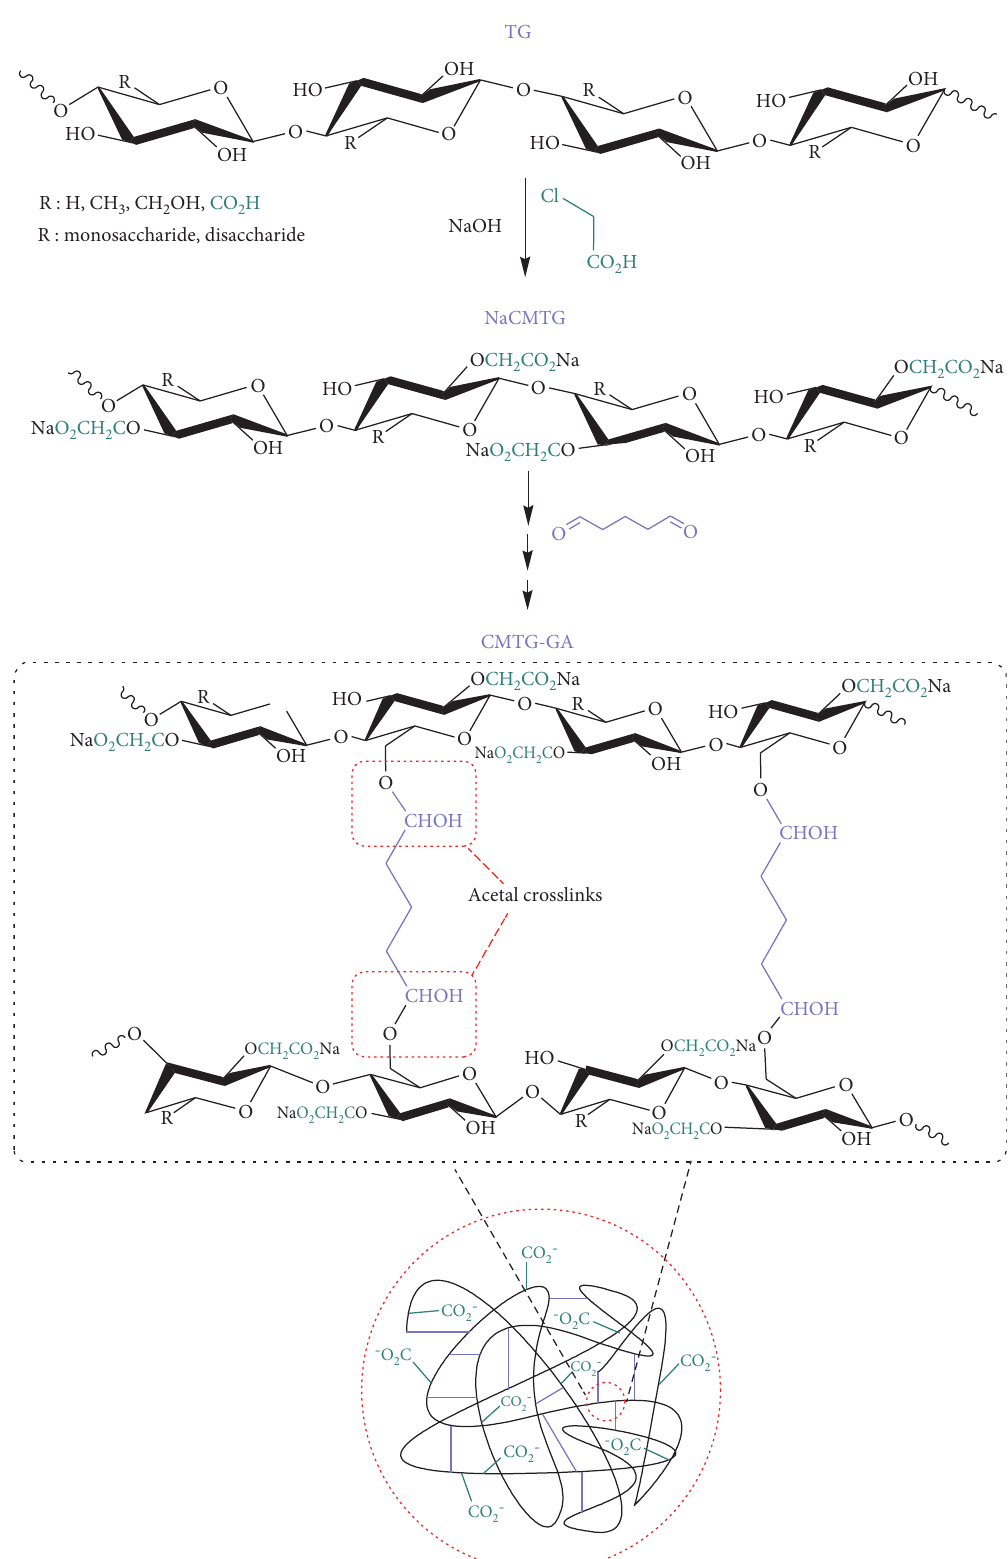
Figure 3: The plausible proposed mechanism for the synthesis of the